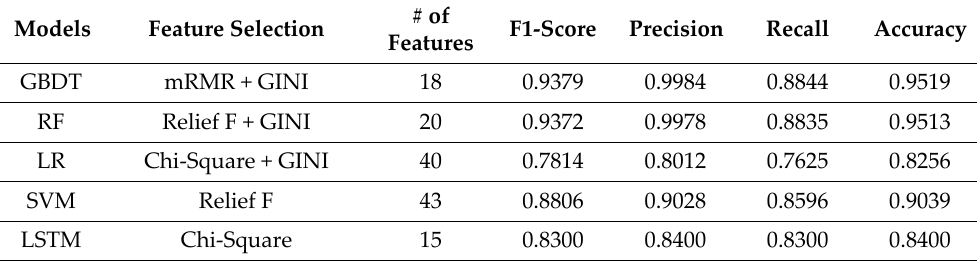
Table 3. Performance of the classifiers trained with the